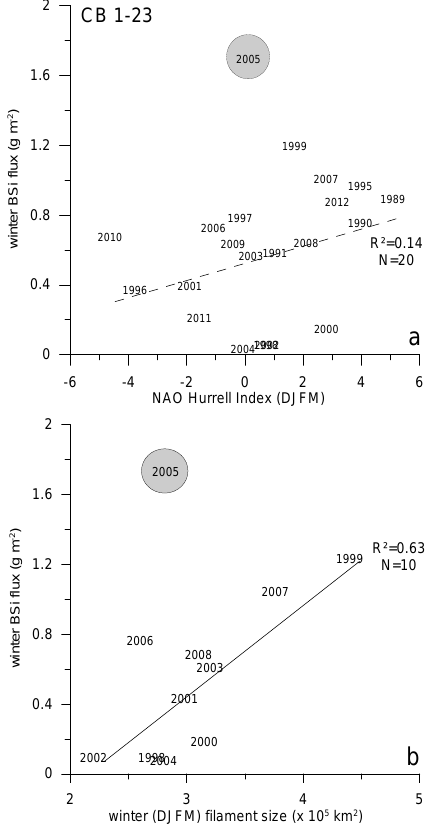
Figure 7. (a) The NAO Hurrell index (DJFM, Hurrell, 1995) plotted against winter BSi fluxes from Fig. 6. Note the increase of BSi with increasing NAO index. However, the relationship is weak due to unusual sedimentation events in the years 1998–1999, 2002, 2004, and, in particular in 2005. When omitting the data point from 2005, the correlation coefficient increases, but remains low ( R 2 = 0.14, N = 20). Upper trap flux data from winter 1998 and 2004 may be too low as the filament with elevated chlorophyll was small and the particles did not reach the upper trap (see text). Omitting these two data point would slightly improve the relationship. (b) The size of the Cape Blanc filament (Fischer et al., 2009b) during win- ter months (DJFM) versus winter BSi fluxes shows higher fluxes with larger filament size. When omitting the BSi flux from winter 2005, a statistically significant relationship between filament size and fluxes is obtained ( R 2 = 0.63, N = 10). Years given in the figure denote the respective winter seasons (e.g. 1999 = December1998– March 1999).